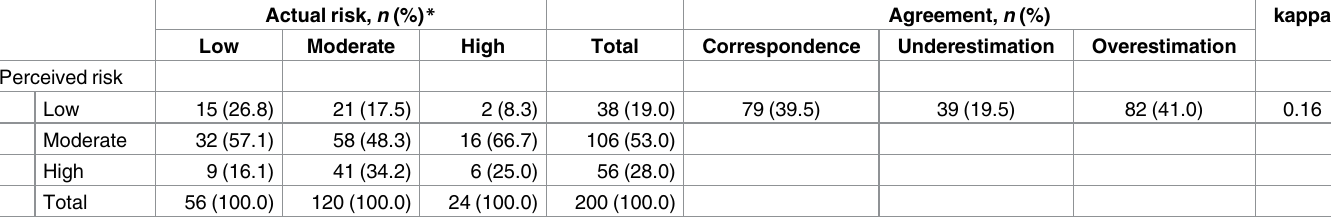
Table 3. Perceived risk and actual risk for CVD in patients with RA free of CVD ( n = 200).